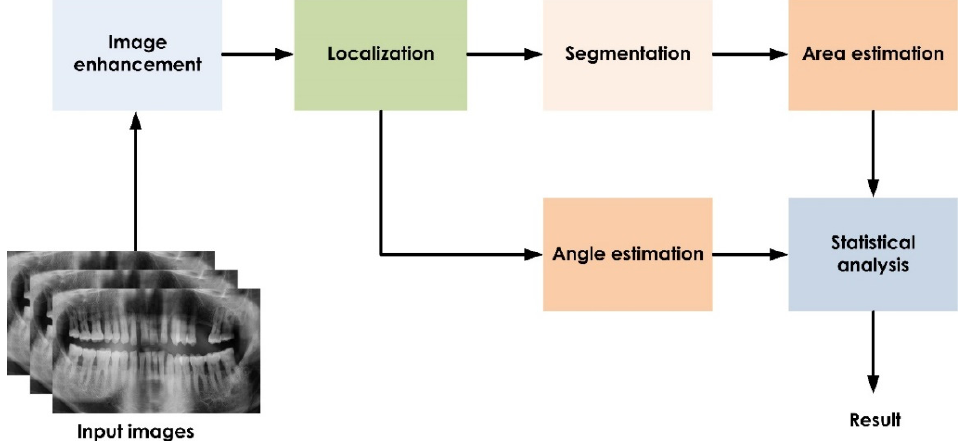
Figure 2. Overview of the proposed approach.